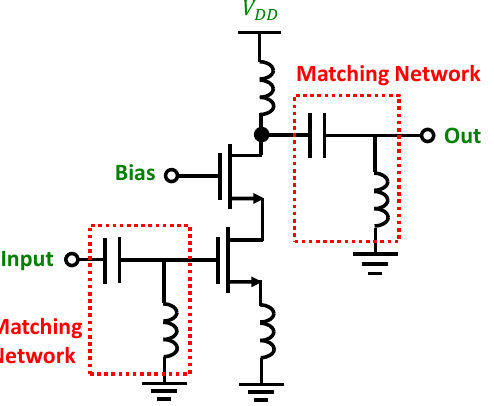
Figure 7. Schematic of the cascode low-noise amplifier circuit used in